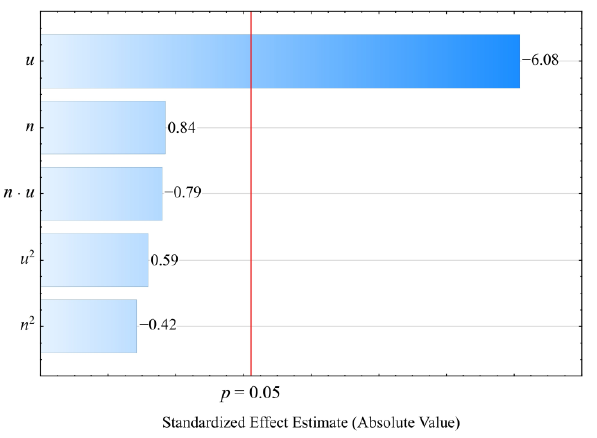
Figure 14. Pareto plots of the standardized effects of empirical full model Vicat softening temperature VST, the vertical line in the plot corresponds to the arbitrarily chosen level of significance ( p = 0.05).